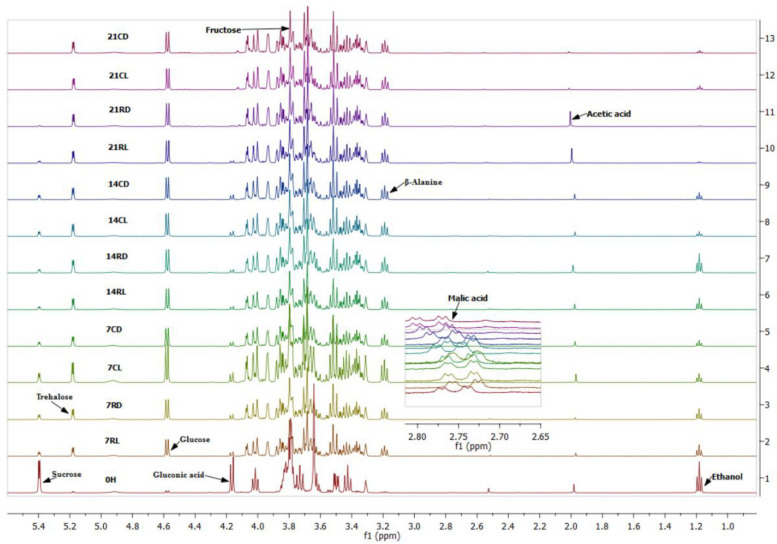
Proton nuclear magnetic resonance (1H-NMR) spectra of soursop kombucha at different storage conditions. Full spectra of δ 1.0–5.5 ppm. Identified 1H-NMR signals: sucrose, fructose, glucose, acetic acid, malic acid, gluconic acid, and ethanol. 7, 14, and 21 days are storage times. R, room temperature; C, chilled temperature; L, light condition; D dark condition.